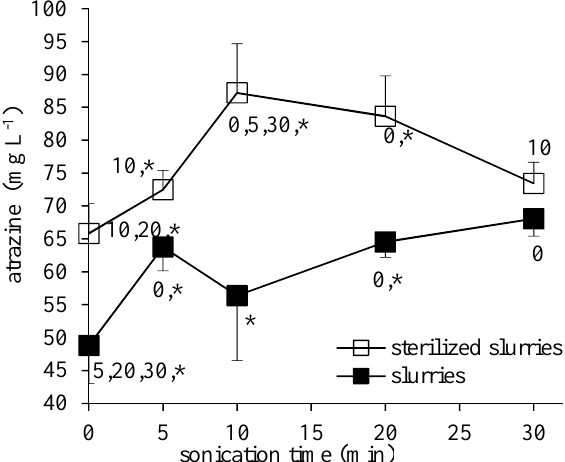
Figure 3. The highest atrazine concentrations in the slurries and sterilized slurries sonicated twice a day for 0 (days 34–36, n = 9, day 6, n = 3), 5 (days 34–36, n = 9), 10 (days 34–36, n = 9), 20 (day 13, n = 3), and 30 (day 13, n = 3) min. Numbers indicate statistically significant differences (Anova, Tukey HSD, p < 0.050) between sonication times, and asterisks indicate statistically significant differences (T-test, p < 0.050) between slurries and sterilized